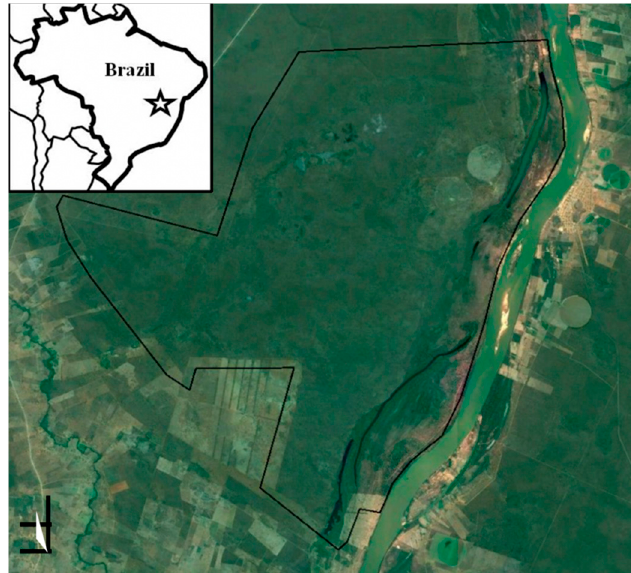
Figure 1. Parque Estatal de Mata-Seca (PEMS), Minas Gerais, Brasil. August 2013.